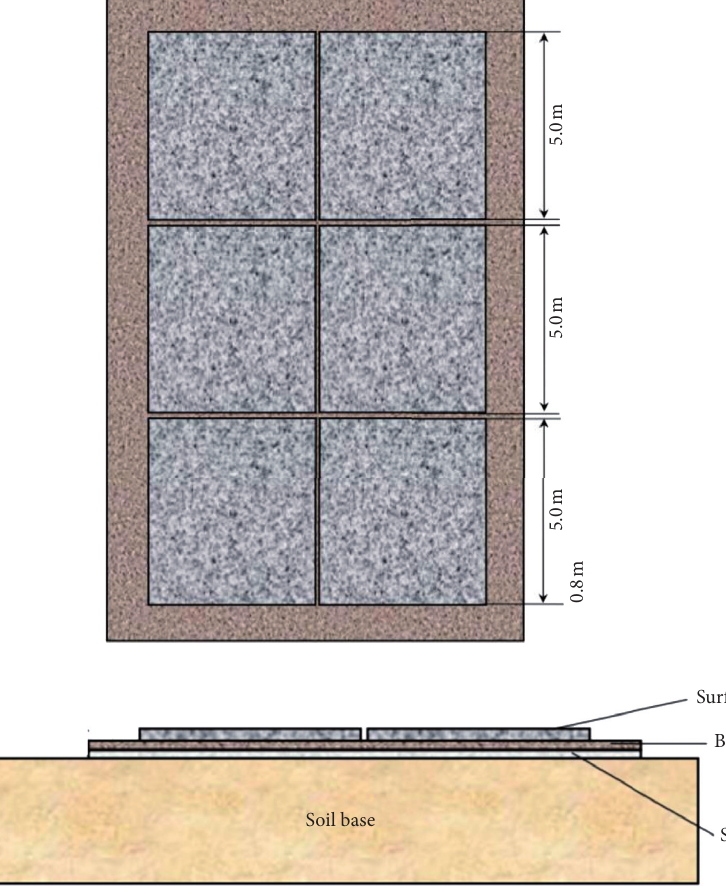
Figure 12: Schematic of full-scale cement concrete pavement structure.